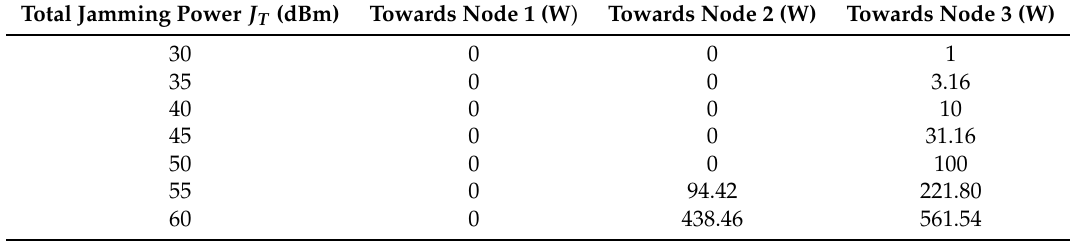
Table 2. Optimized interference power towards 3 radar nodes versus total jamming power in the second experiment of Scenario 1.